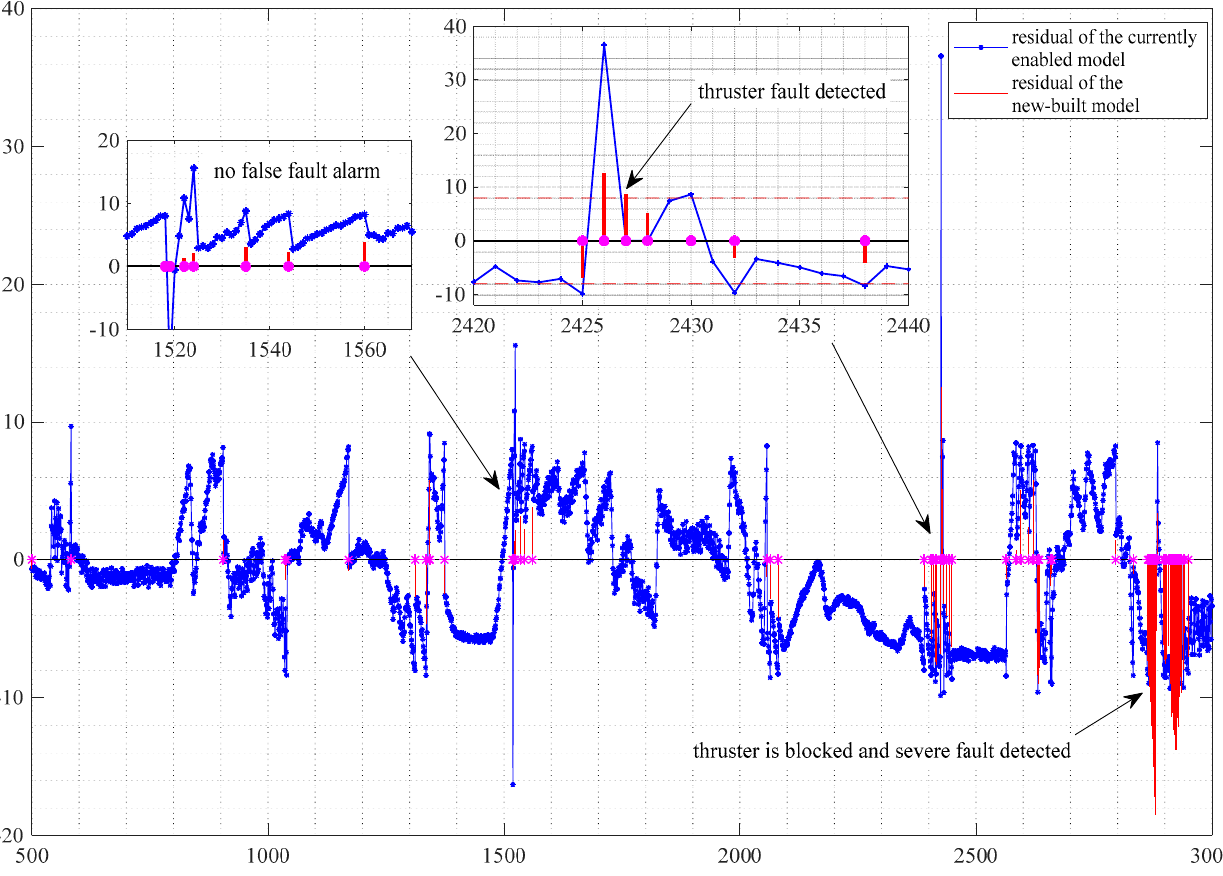
Figure 19. Model residuals of the online learning-based fault detection method during sea trial of the portable AUV.